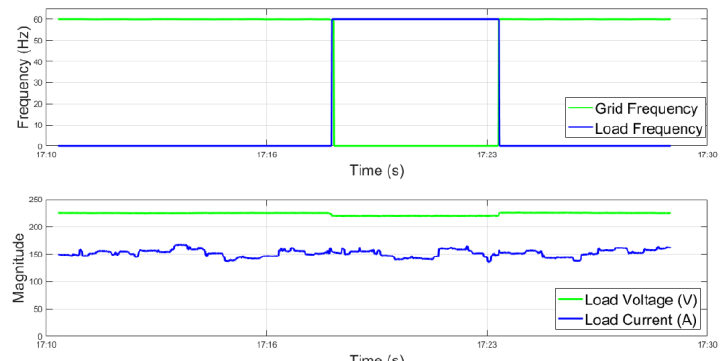
Figure 15. Action of BESS as a voltage and frequency reference for the load during disturbance in the frequency of the voltage of the utility grid.